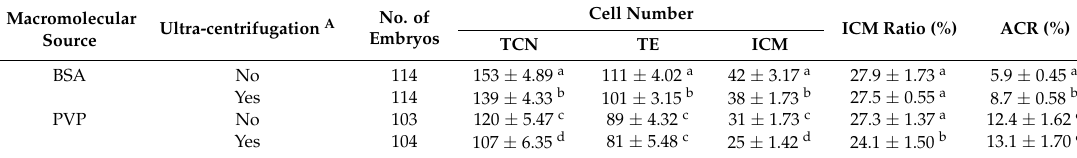
Table 2. Quality assessment of embryos cultured in BSA and PVP Macromolecular